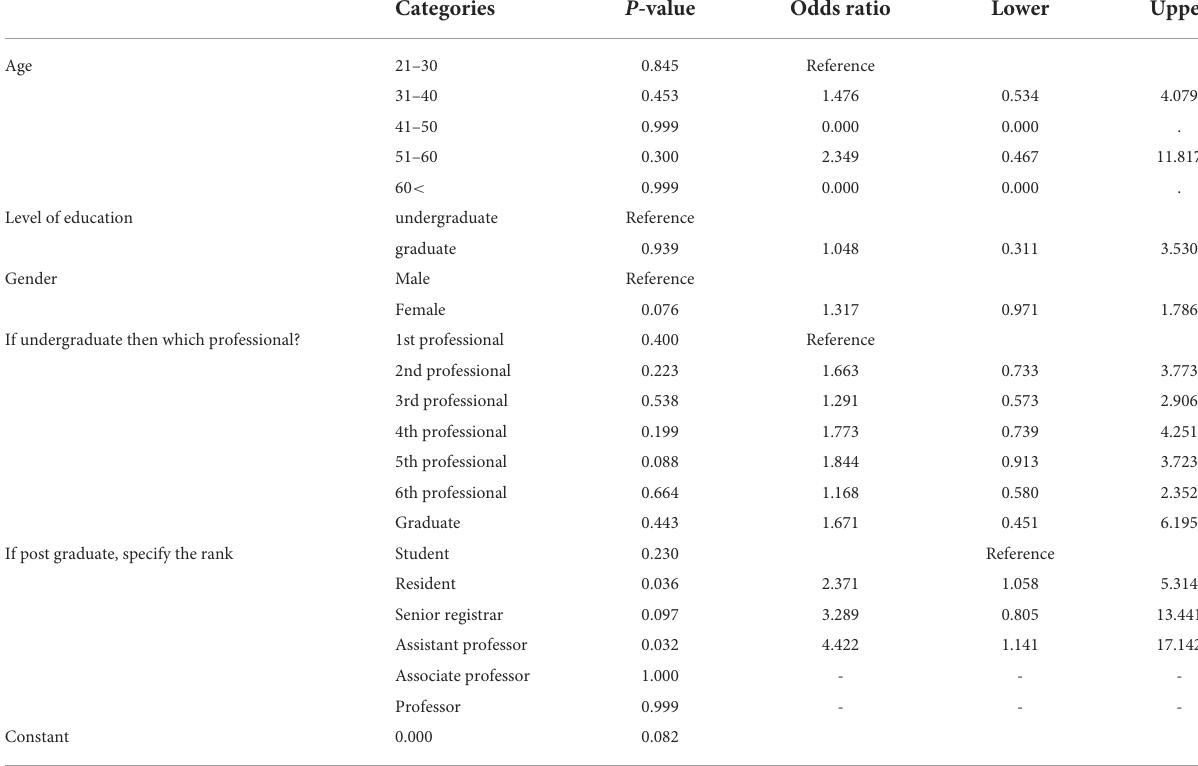
TABLE 11 Binary logistic regression between baseline characteristics of the study population and the Practice of artificial intelligence ***